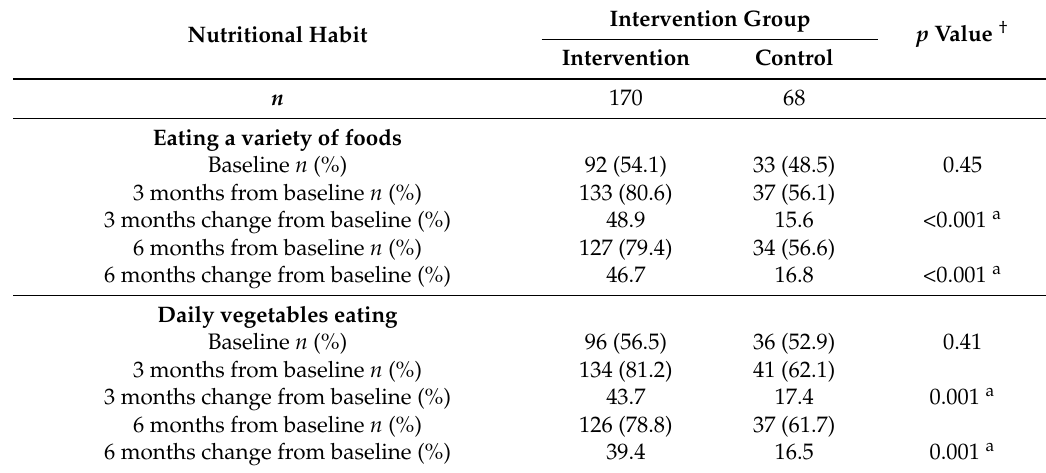
Table 2. Changes in children’s nutritional habits * by study arm during a single school